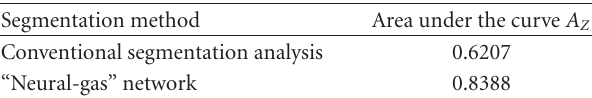
Table 5: Results of the comparison between the two di ff erent segmentation methods for the 40 small lesions: the average area under the curve A Z and its deviations for 20 di ff erent ROC runs using the same parameters but di ff erent algorithms’